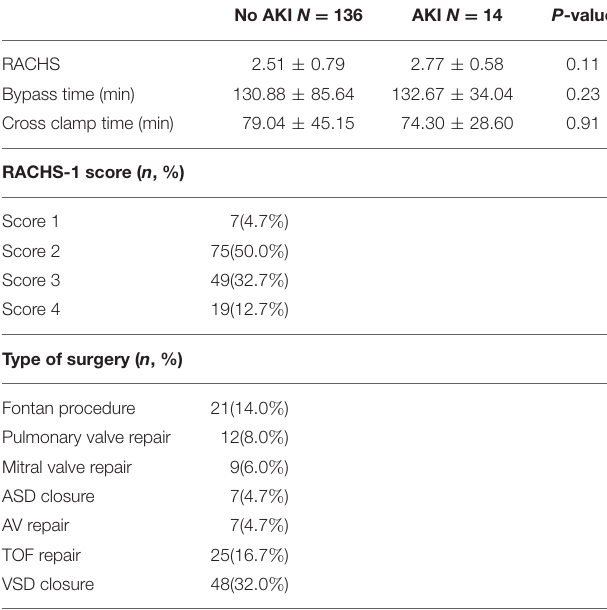
TABLE 2 | Type of surgeries and surgical characteristics of patients ( N = 150).